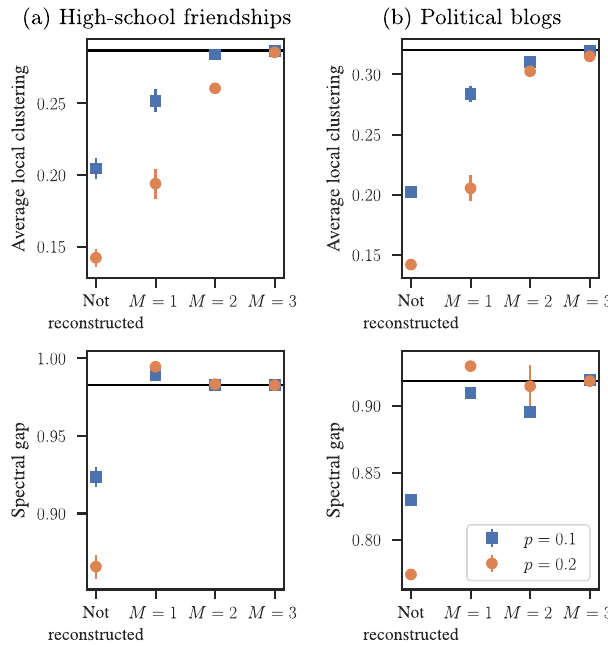
Fig. 1 | Network descriptors measured from noisy networks and their recon- struction. We investigate two empirical networks: a friendships between high school students and b hyperlinks between political blogs — measured with a simulated missing edge probability p , and spurious edge probability